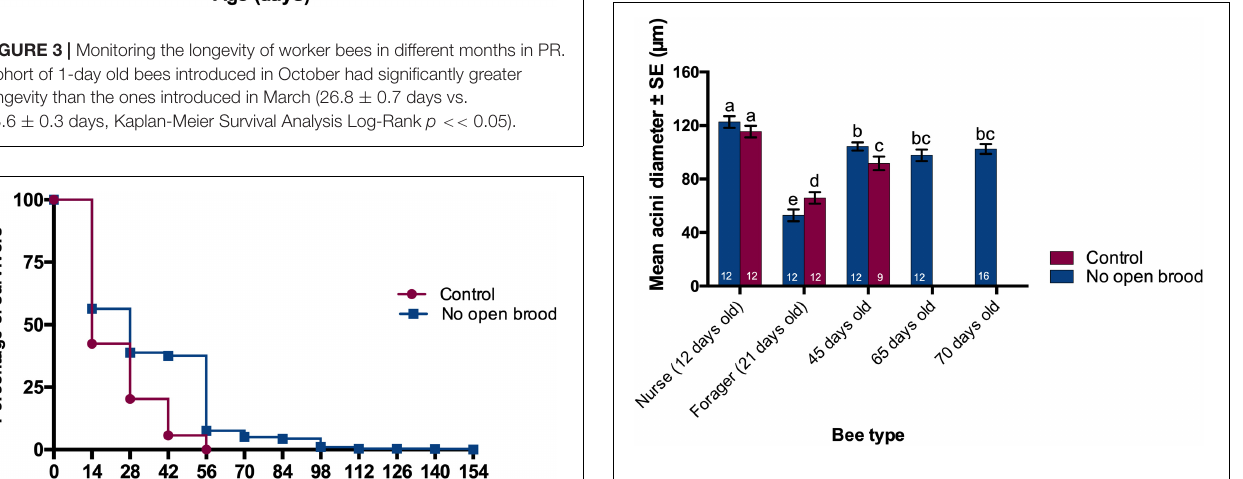
FIGURE 5 | Acini size of different bees collected at different times from treatment and control colonies. Hypopharyngeal gland acini size were significantly different between groups; largest in nurses, smallest in foragers, and intermediate in the long-lived winter-like bees (ANOVA, p << 0.05). Different letters denote significant differences in acini size between groups (Student’s t -Test, p <